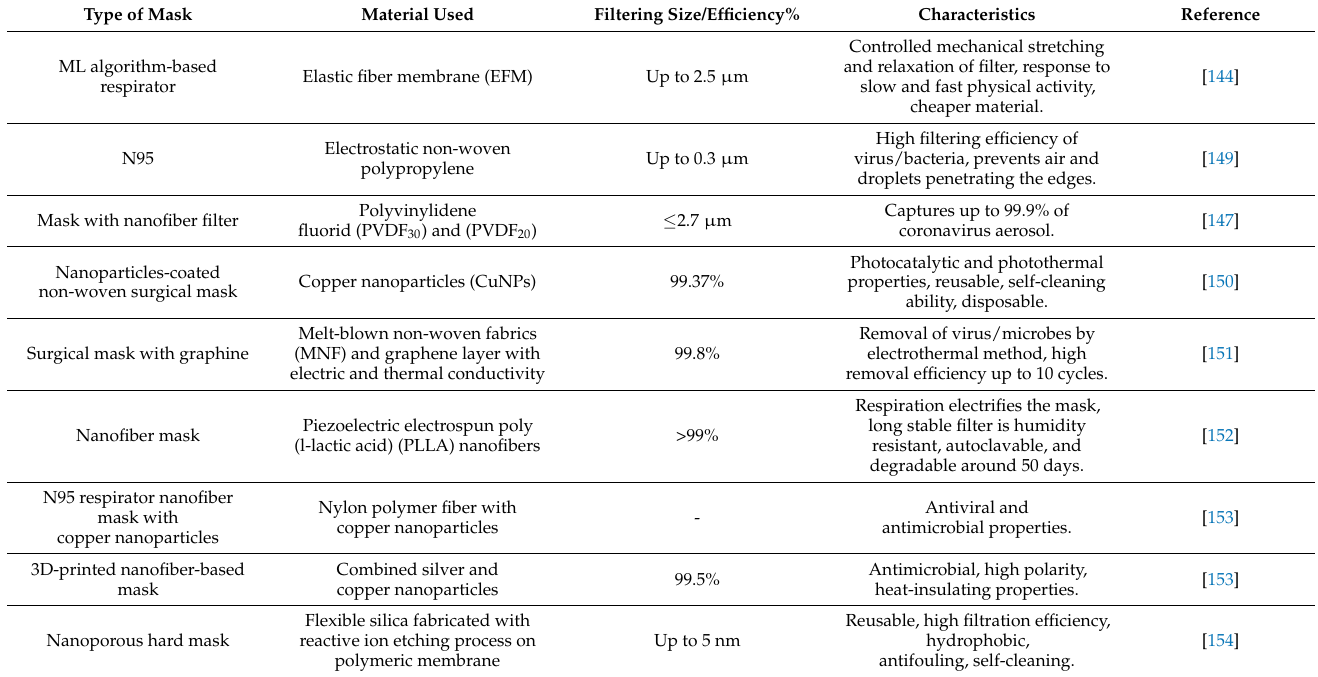
Figure 9. Illustration of a nanofiber mask with 3 layers of protection against micro-aerosol droplets with coronavirus. Table 3. Overview of various mask materials produced through nanofiber/material technologies to confront the